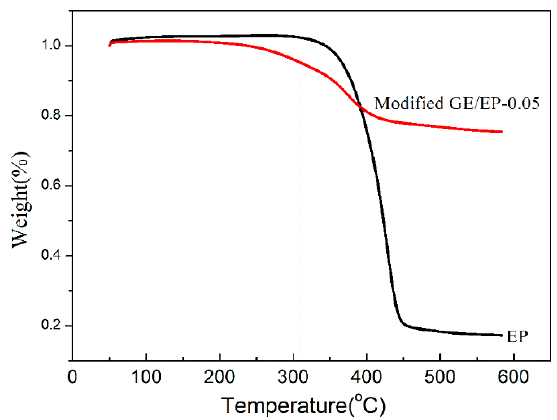
Figure 7. TG of EP and modified GE/EP composite filled with 0.05 wt % modified GE.